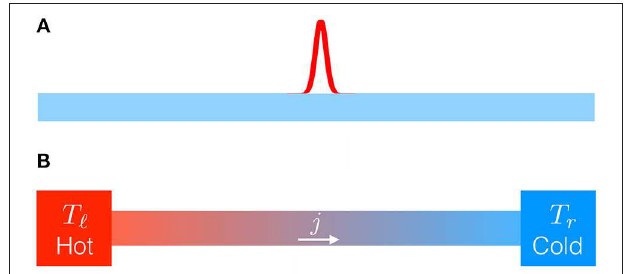
FIGURE 1 | Schematic illustration of the (A) closed system set-up and the (B) open system set-up, commonly used to study heat transport. In (A) , a localized heat pulse is introduced at some point in a system in thermal equilibrium and its subsequent time-evolution is observed. In (B) , the system is attached to two heat reservoirs at different temperatures and the NESS properties, such as current and temperature profile are studied.